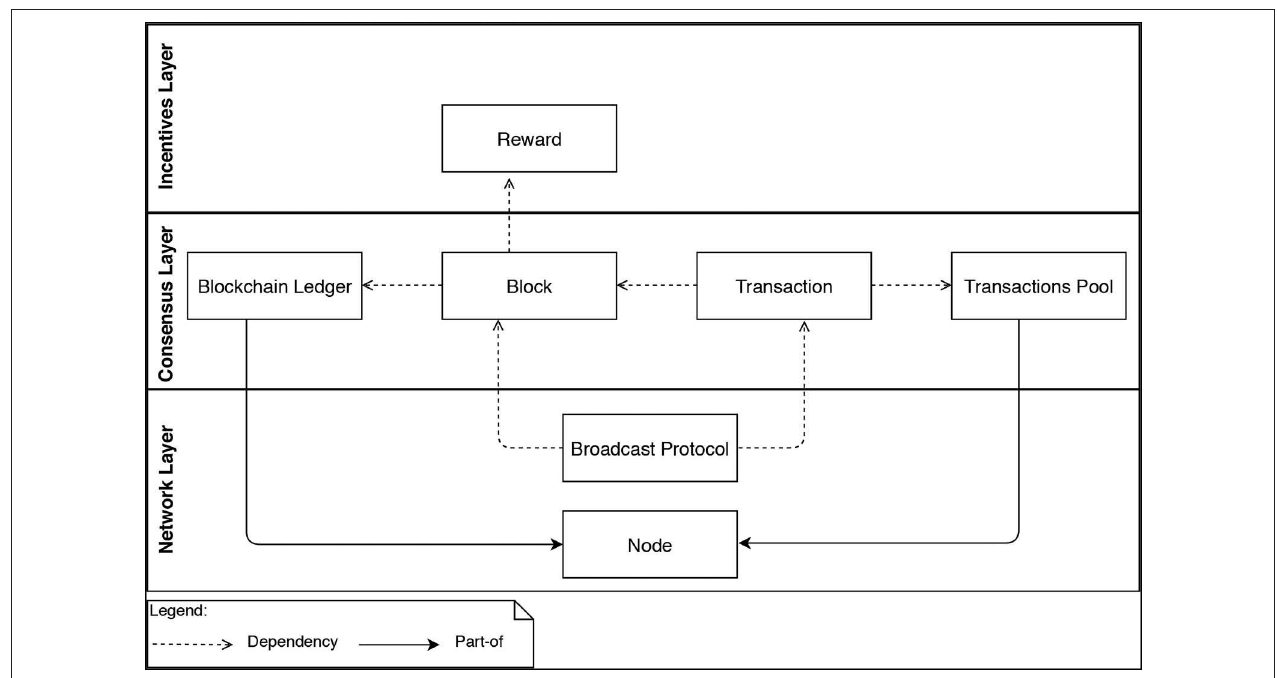
FIGURE 2 | BlockSim model